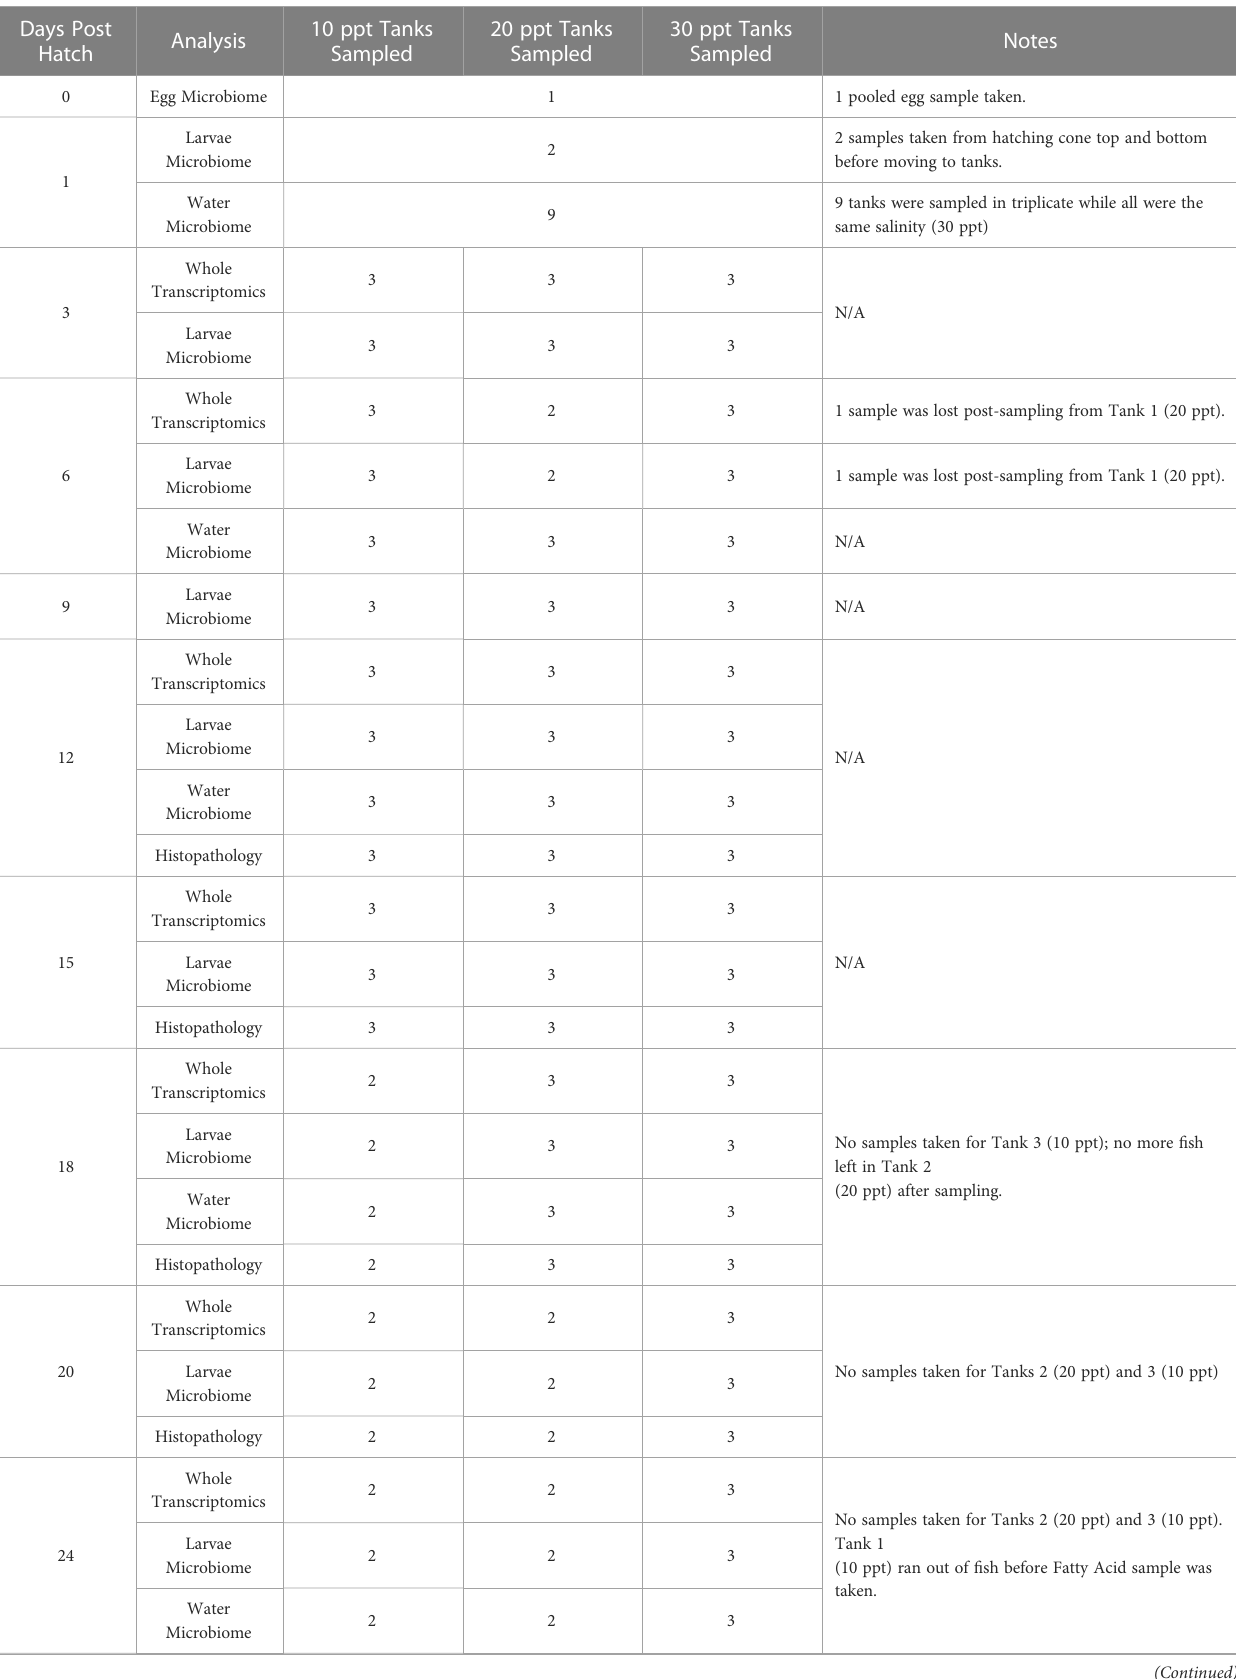
TABLE 1 Summary of tanks sampled for whole transcriptomics, larvae microbiome, water microbiome, and histopathology in Florida pompano (Trachinotus carolinus ) larvae sampled from 0 to 24 days post hatch at three salinities (10, 20, and 30